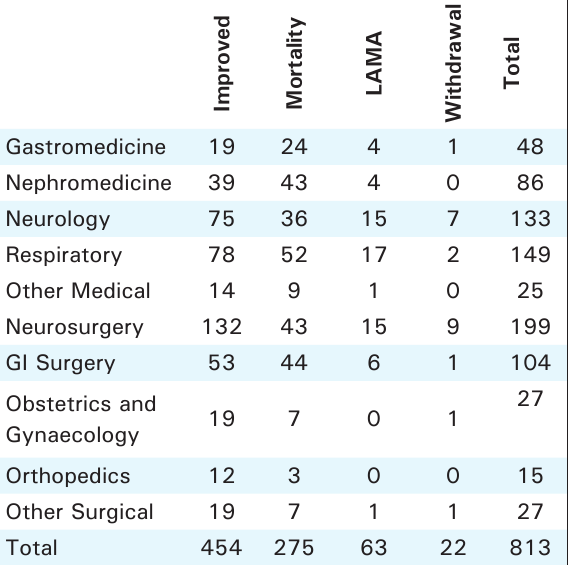
Figure 4. Outcome of patients in TUTH ICU. Also, mortality was only 3 (23.07%) in those aged below 15 (out of 13), 181 (30.31%) in those aged 15 to 65 years (out of 597), and 84 (41.37%) in those aged more than 65 years (out of 203). Outcome of the patients according to their primary specialty is shown (Table 1). Table 1. Outcome of patients according to primary